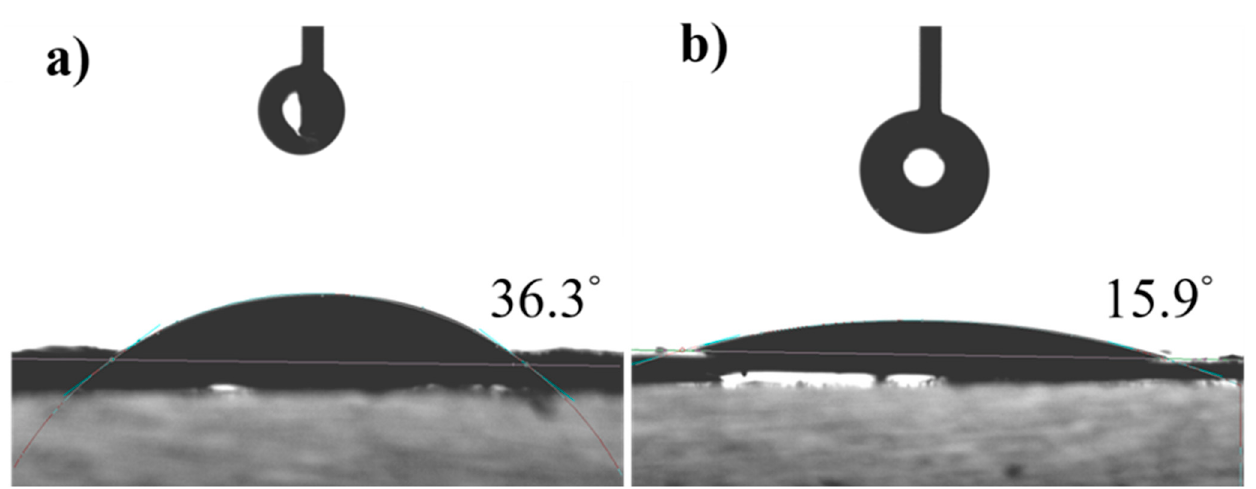
Figure 2. Water contact angle measurement of ( a ) CeO 2 -ZIF-8 and ( b ) CeO 2 substrates.